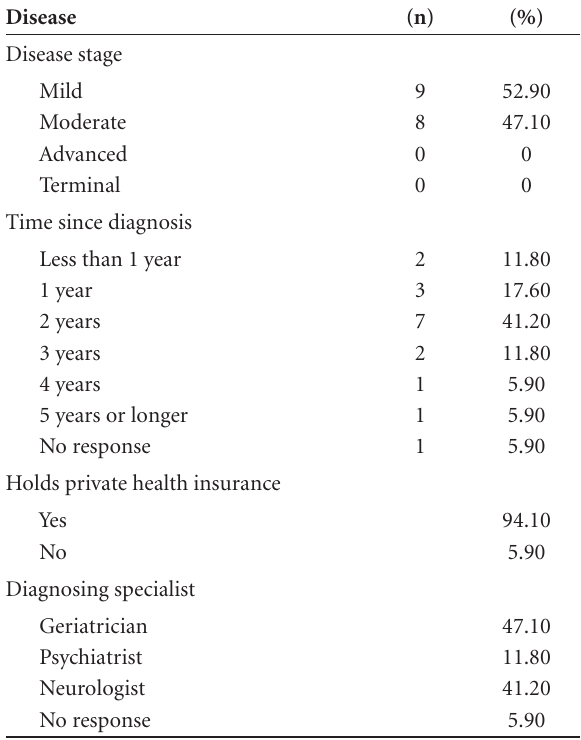
Table 2. General data on elderly patients with AD. Disease